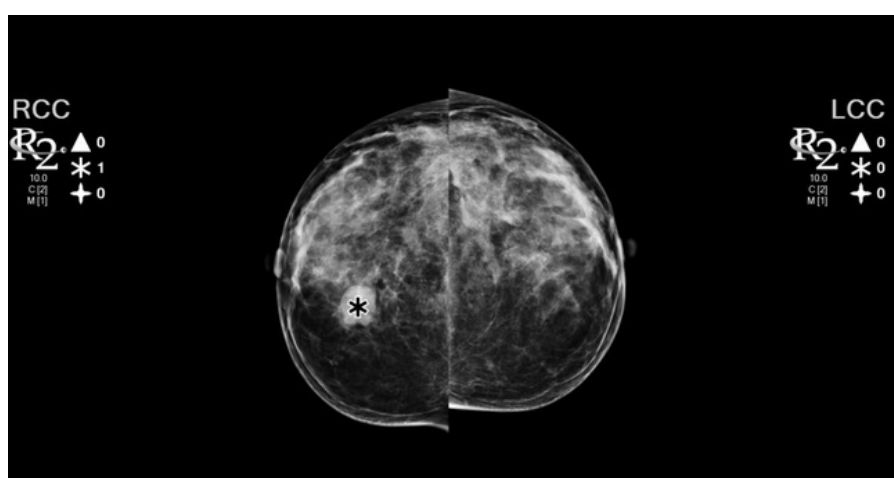
Figure 4. A nodule was detected by the CAD tool in the right breast (asterisk). LCC: left craniocaudal view; RCC: right craniocaudal